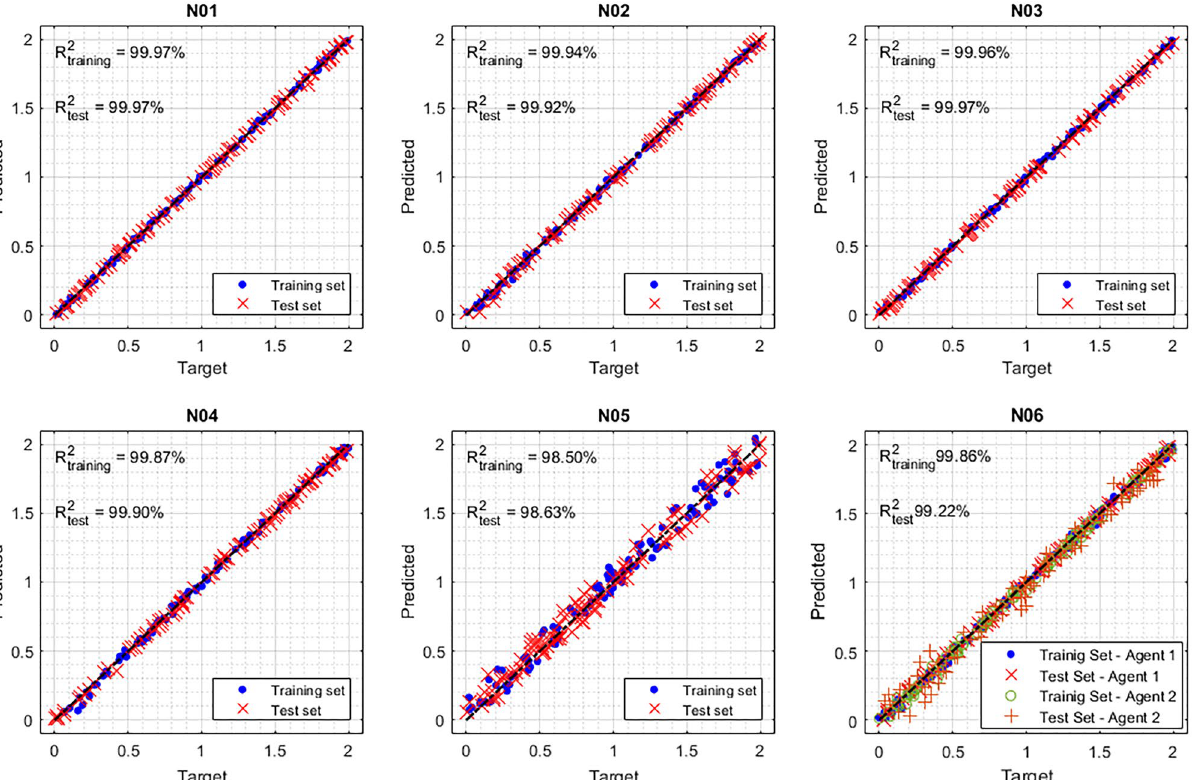
Figure 3. Results obtained in the six synthetic cases. Each figure shows the target concentration vs the predicted concentration for the six synthetic cases for both training and test